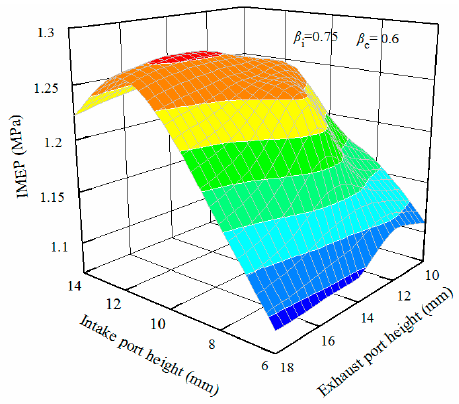
Figure 14. Effect of the intake and exhaust port height on IMEP.